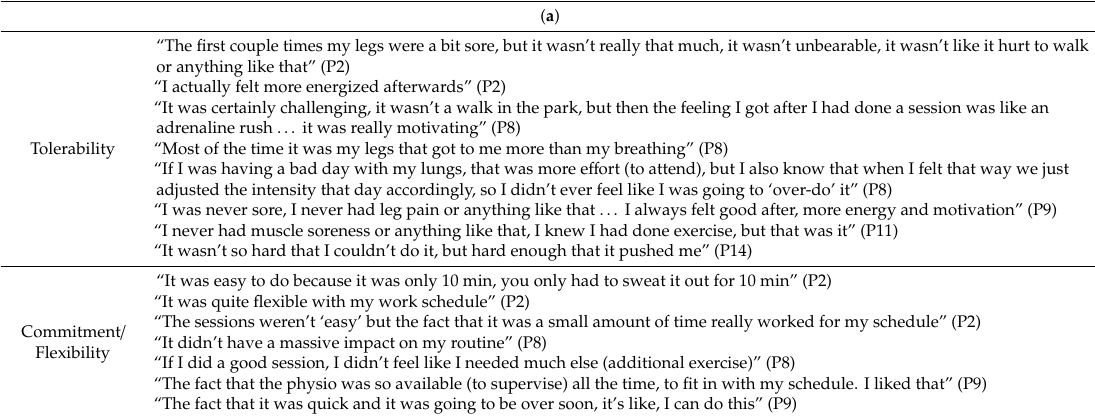
Table 3. Note: P = participant number. ( a ) Debrief themes—facilitators; ( b ) Debrief